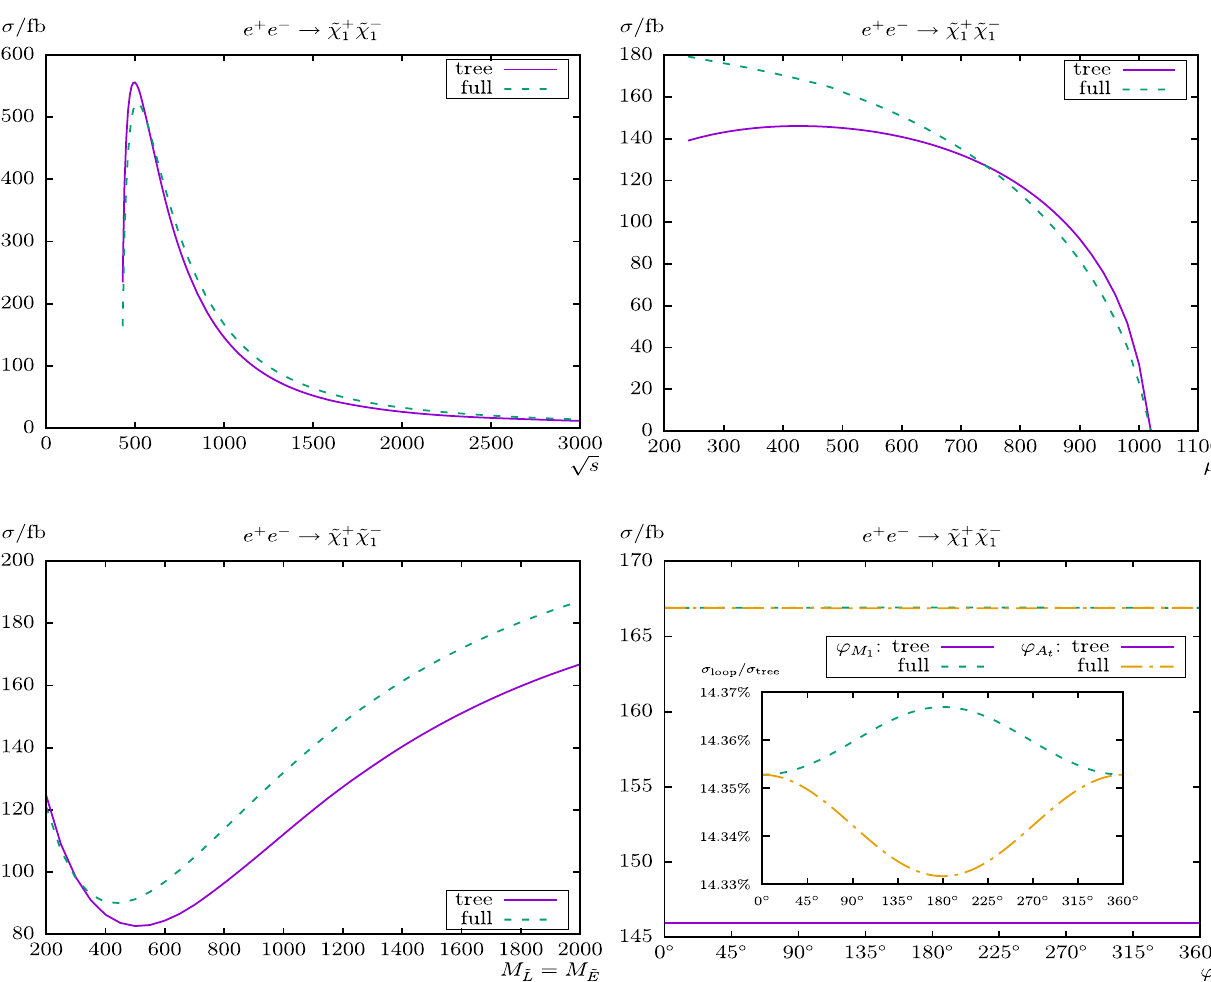
˜ χ − ) . Tree-level and full one-loop corrected cross sections are shown with parameters chosen according to S ; see Table 2. √ 1 1 s (left) and μ (right) varied; the lower plots show M ˜